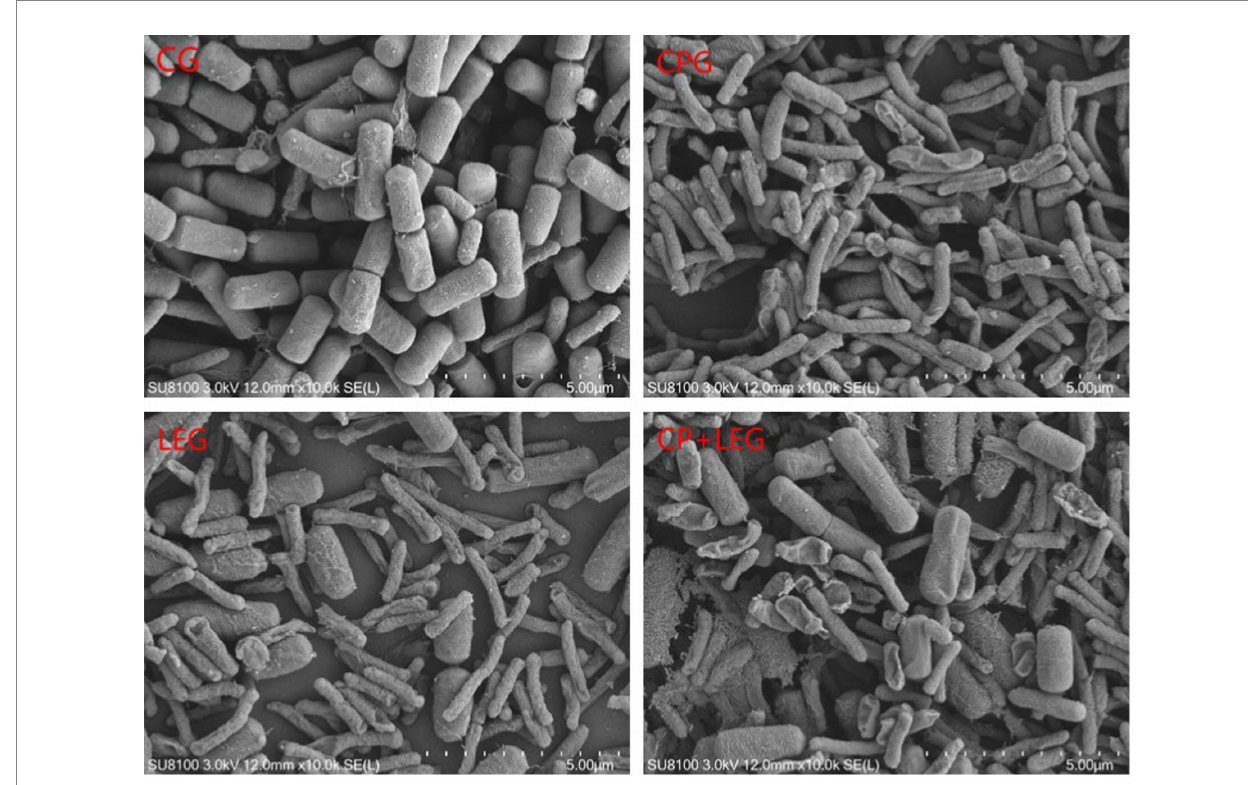
FIGURE 6 Effects of preservation methods on the morphology of Pseudomonas. CG, the control group; CPG, the compound preservative group; LEG, the low voltage variable frequency electric field group; CP+LEG, the compound preservative combined with low voltage variable frequency electric field